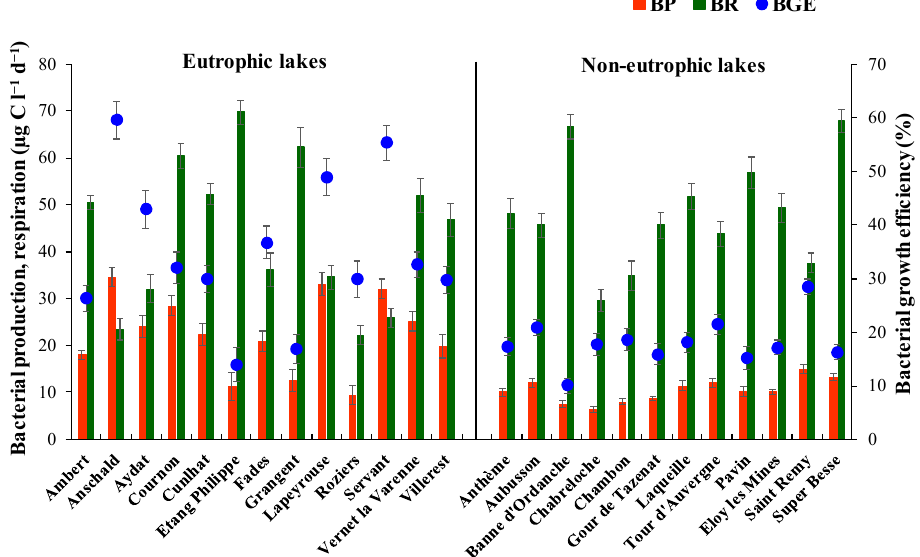
Figure 2. Estimates of bacterial production (BP), respiration (BR) and calculated growth efficiency (BGE) in the eutrophic and non-eutrophic set of lakes. Data represent mean ± SD (n = 3).